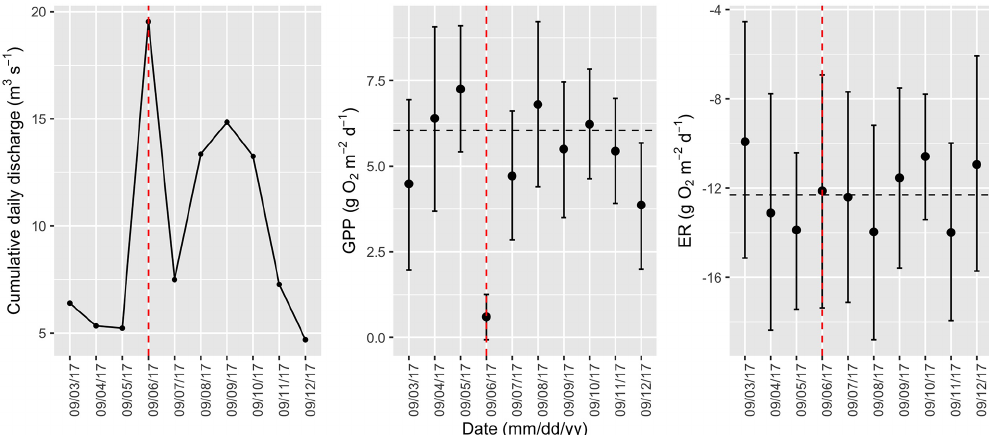
Figure A17. Cumulative daily discharge and metabolism (gross primary production and ecosystem respiration; GPP and ER) time series for the Stroubles Creek flow event on 6 September 2017 (noted with a dashed vertical red line in all three panels). The dashed horizontal black lines are mean values of GPP and ER prior to the high flow event. Error bars for posterior estimates of GPP and ER are 2.5% and 97.5% Bayesian credible